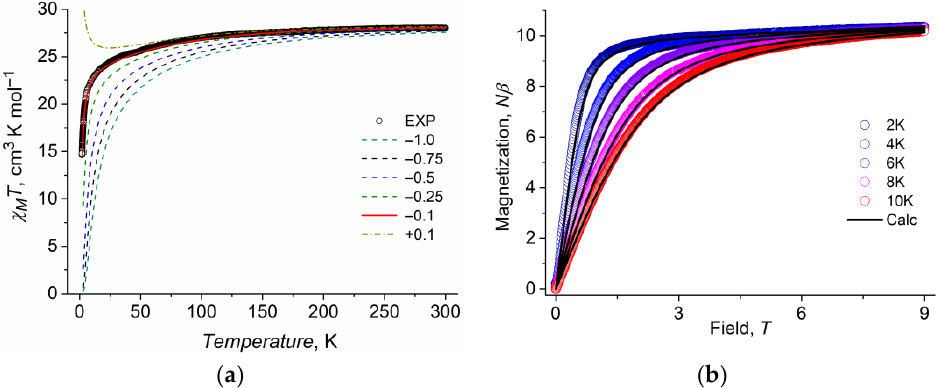
Figure 3. ( a ) DC magnetic susceptibilities for complex 1 . The solid red line represents the best POLY_ANISO simulated data within J ex = −0.1 cm −1 , while the dashed lines represent the POLY_AN- ISO simulated data with different J ex values. ( b ) Field-dependent magnetization at 2, 4, 6, 8, and 10 K for complex 1 . The solid black lines represent the POLY_ANISO simulated data.